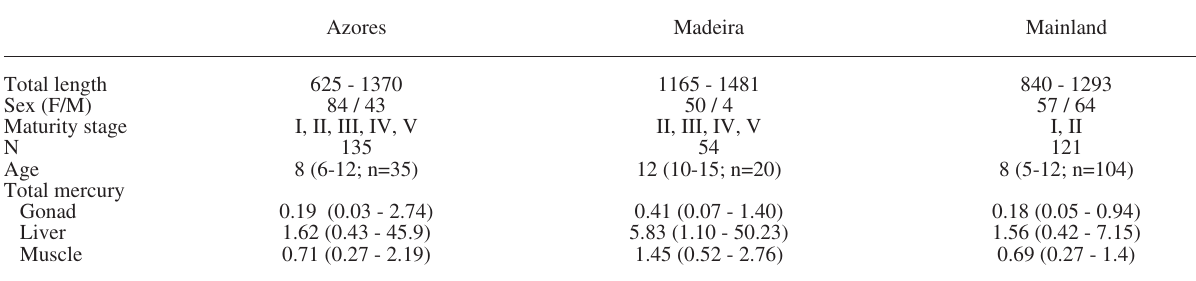
Table 1. – summary of the descriptive statistics of the mercury analyses for the three tissues from the azores, Madeira and Mainland: range of total length (mm); number of specimens by sex; maturity stages available for each geographic region; number of specimens sampled (n); mean and age range (years) and number of specimens aged; and median and range of total mercury concentration (mg/kg ww).